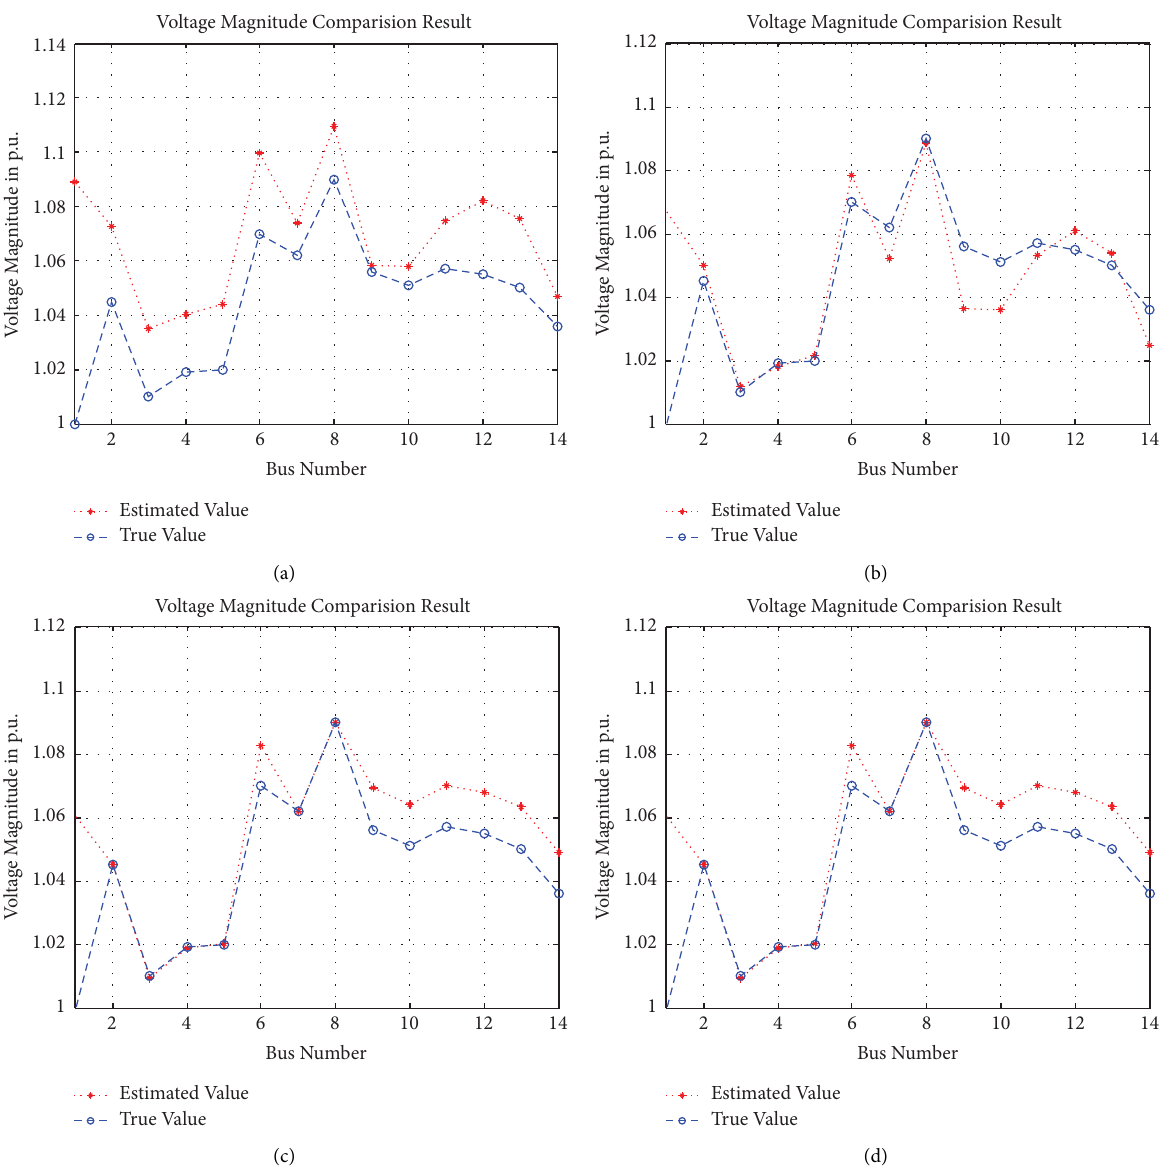
Figure 3: Comparison of true and estimated values for the magnitude of bus voltage in the 14-bus network by performing scenarios 5 and 6